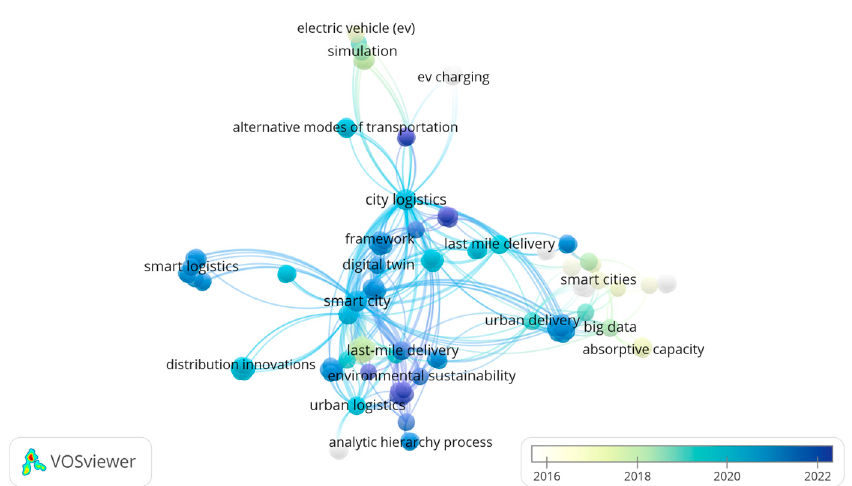
Figure 3. Distribution of papers by year (adopted from Scopus).